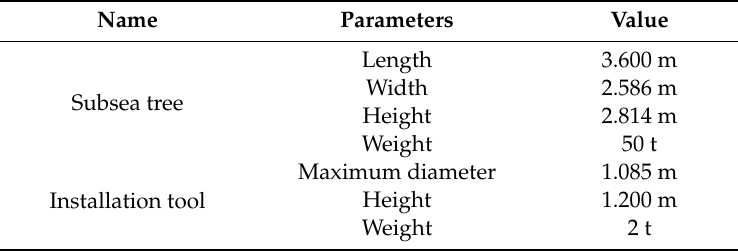
Table 4. The subsea tree and installation tool parameters.